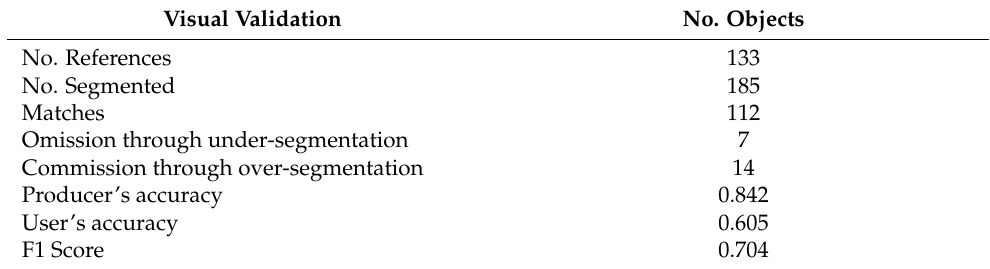
Table 5. Visual assessment metrics of the segmentation of the buildings in the Niger case study.